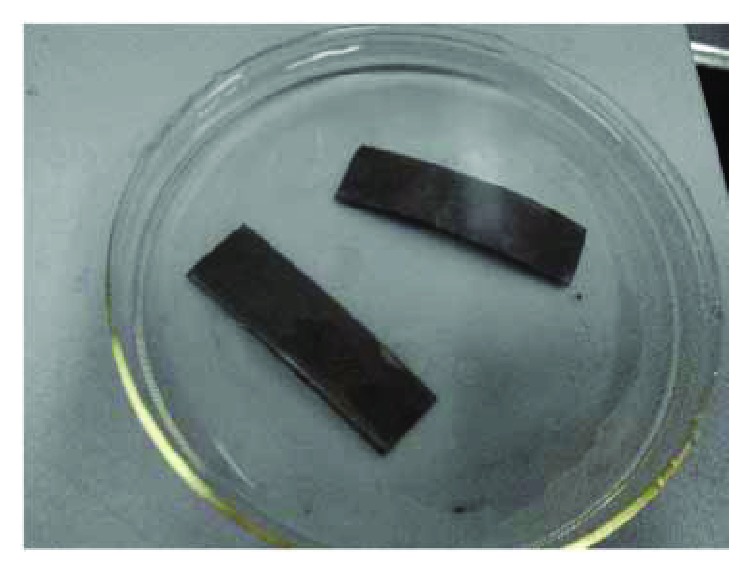
Casted IPMC sample.